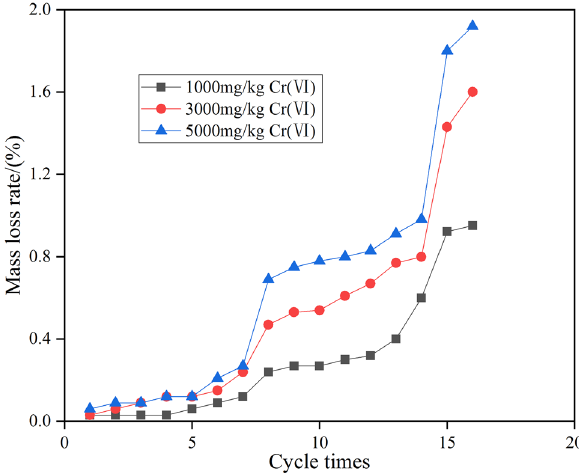
Figure 3. Change of cumulative mass loss rate during dry wet cycle.